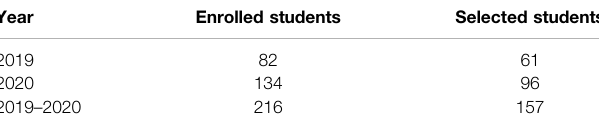
TABLE 1 | Data set